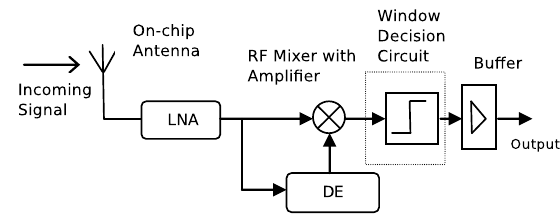
Figure 1. A modified ultra wideband receiver including a delay ele- ment and a window decision